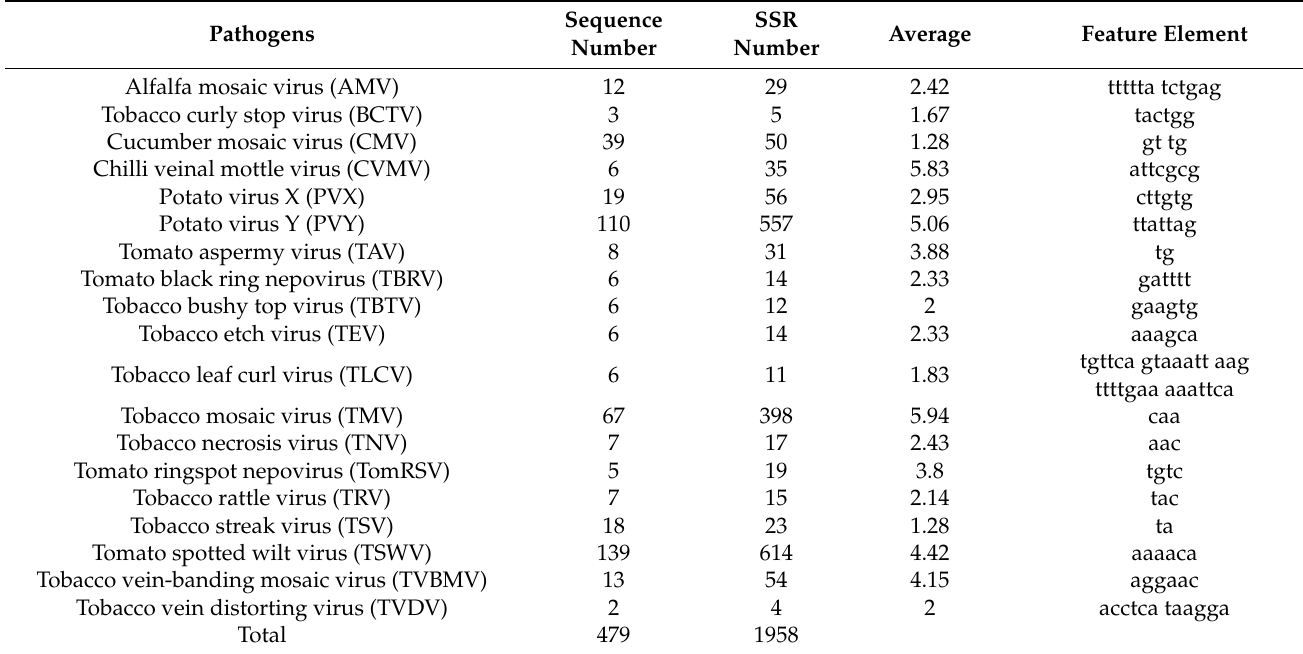
Table 5. SSRs in 19 Nicotiana